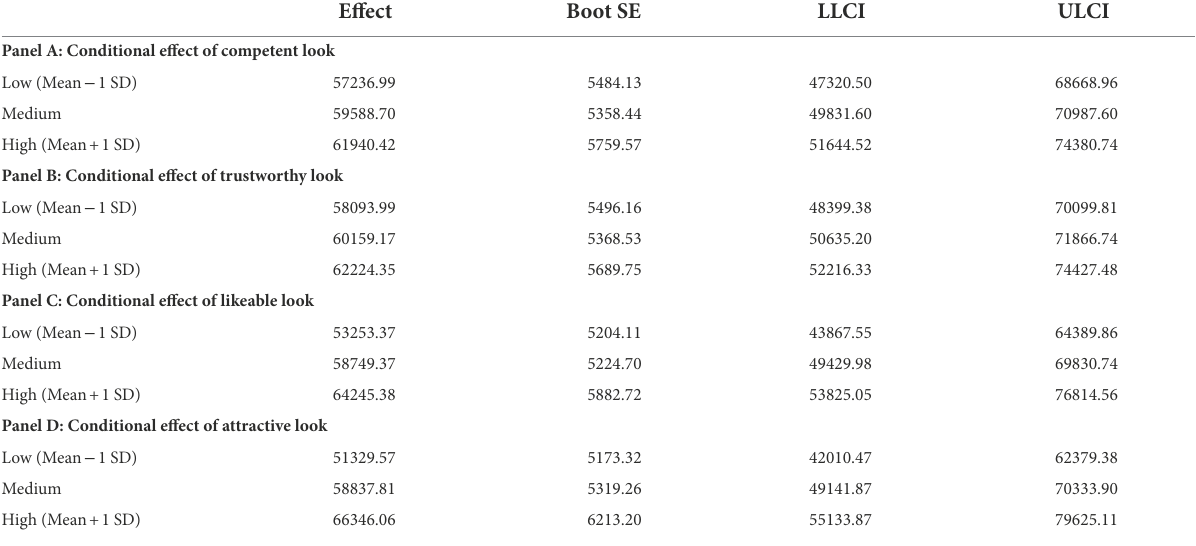
TABLE 7 Conditional indirect effect of various dimensions of broadcaster appearance when mediated by viewer